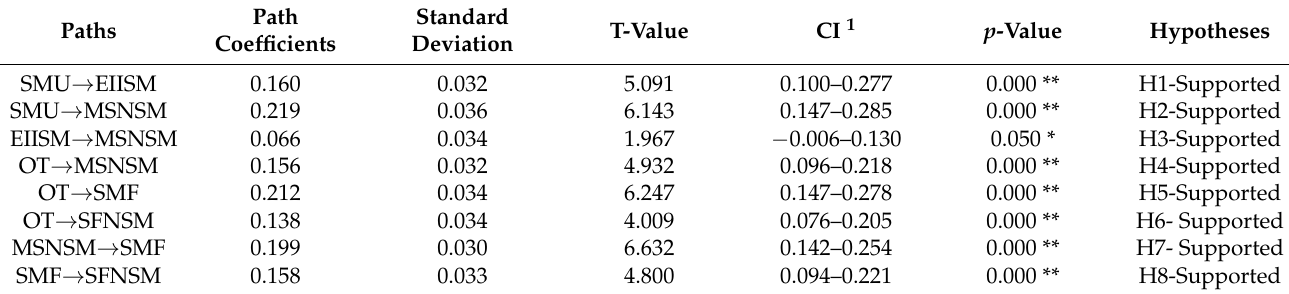
Figure 2. Structural model: Prerequisites of Sharing Fake News on Social Media. Table 5. The path coefficients of the structural equation